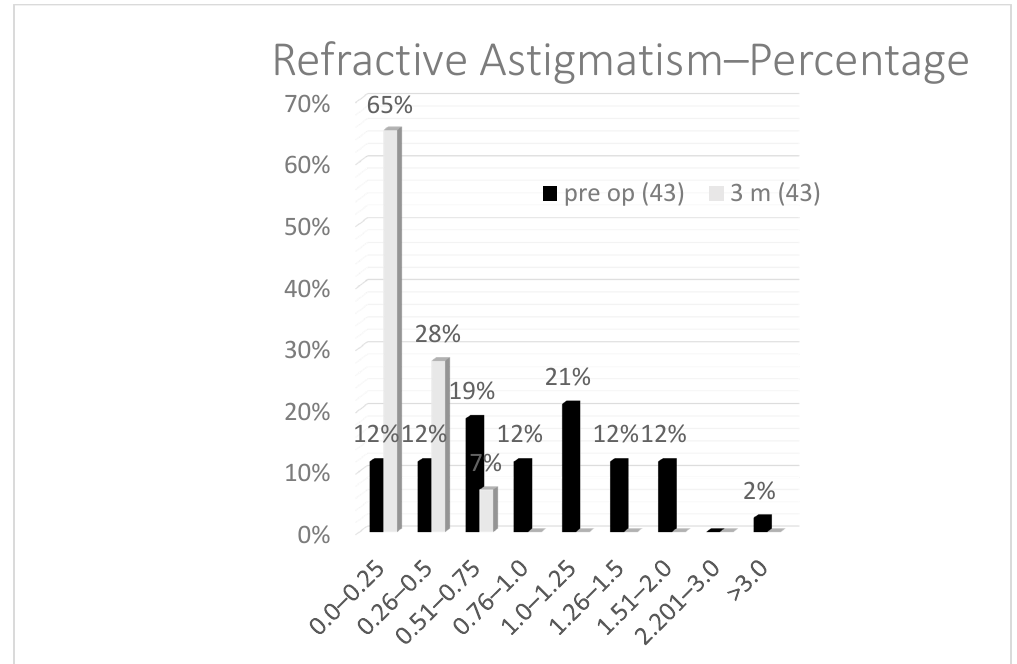
Figure 2. Safety. Comparing lines of vision preoperatively and 3 months postoperatively. No eye lost two or more lines after TransPRK in the eyes treated with clear lens extraction, and 4% of the eyes gained two lines of Snellen acuity.